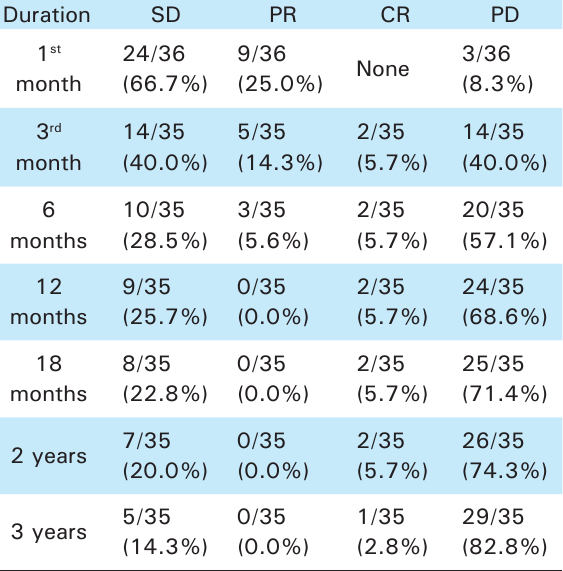
Table 2. Response rates in NSCLC patients treated with